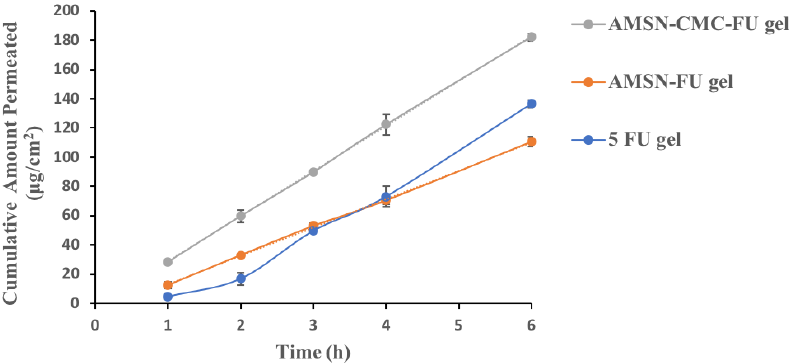
Figure 9. Ex vivo permeation of AMSN-FU gel, AMSN-CMC-FU gel, and 5-FU gel. The results are the mean of three measurements with standard deviation (Mean ± SD, n = 3).